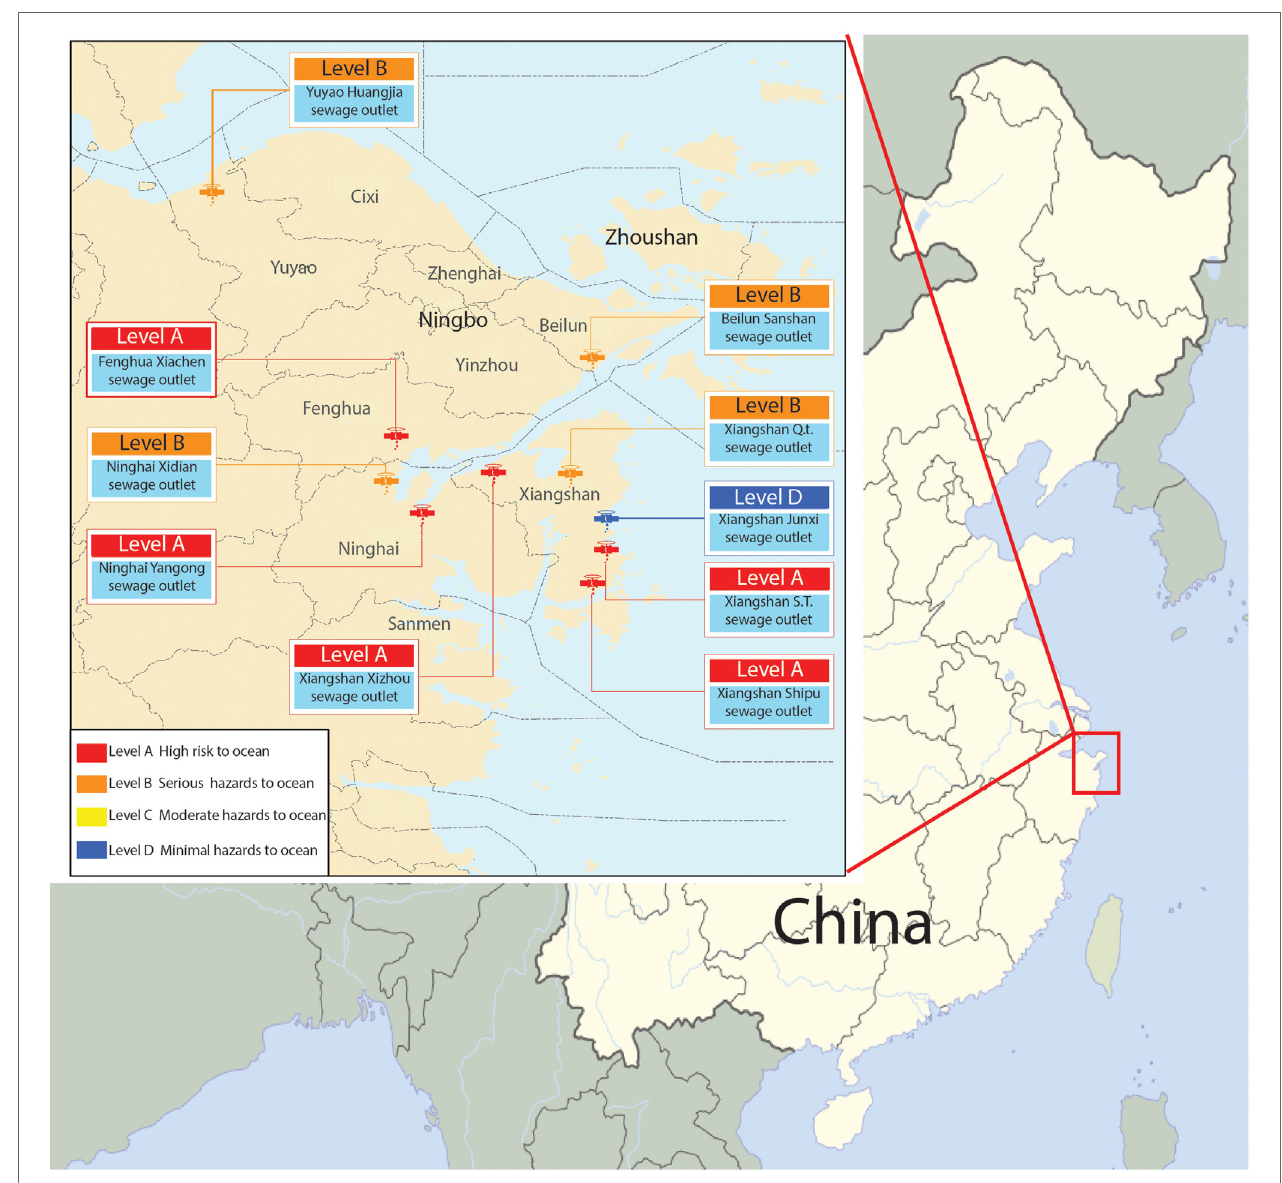
FigUre 1 | Map of 10 terrestrial sewage outlets sites in coastal areas of ningbo